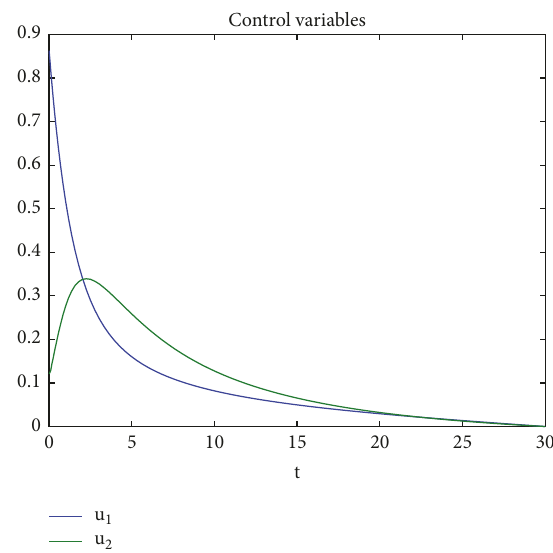
Figure 10: Evolution of number of 𝑦(𝑡) with or without control. and releasing official information strategies to control rumor.